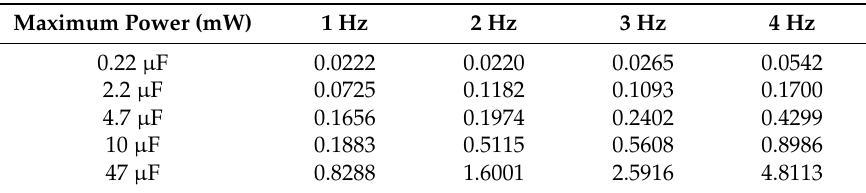
Table 3. Maximum output power of charging different capacitors under hand clapping movements under different